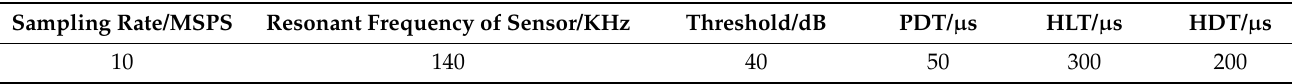
Table 2. Parameter settings of AE